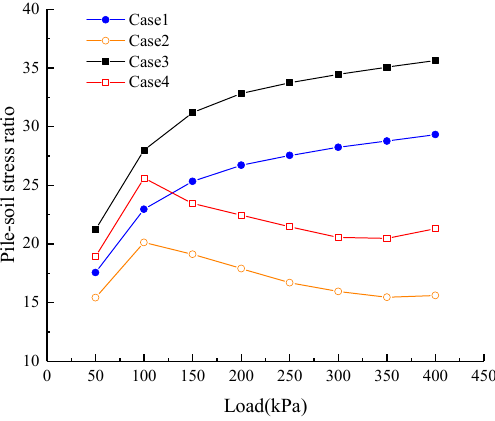
Figure 19. Curve of pile–soil stress ratio.